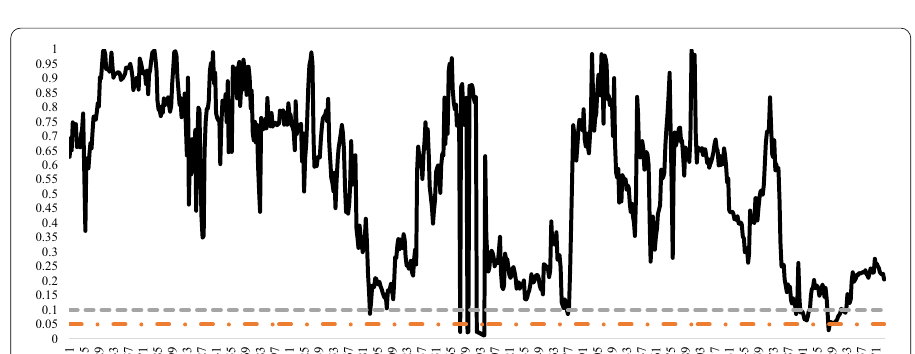
Fig. 19 The evolving p values of the AQ test statistic checked for the WTI in 150-day window